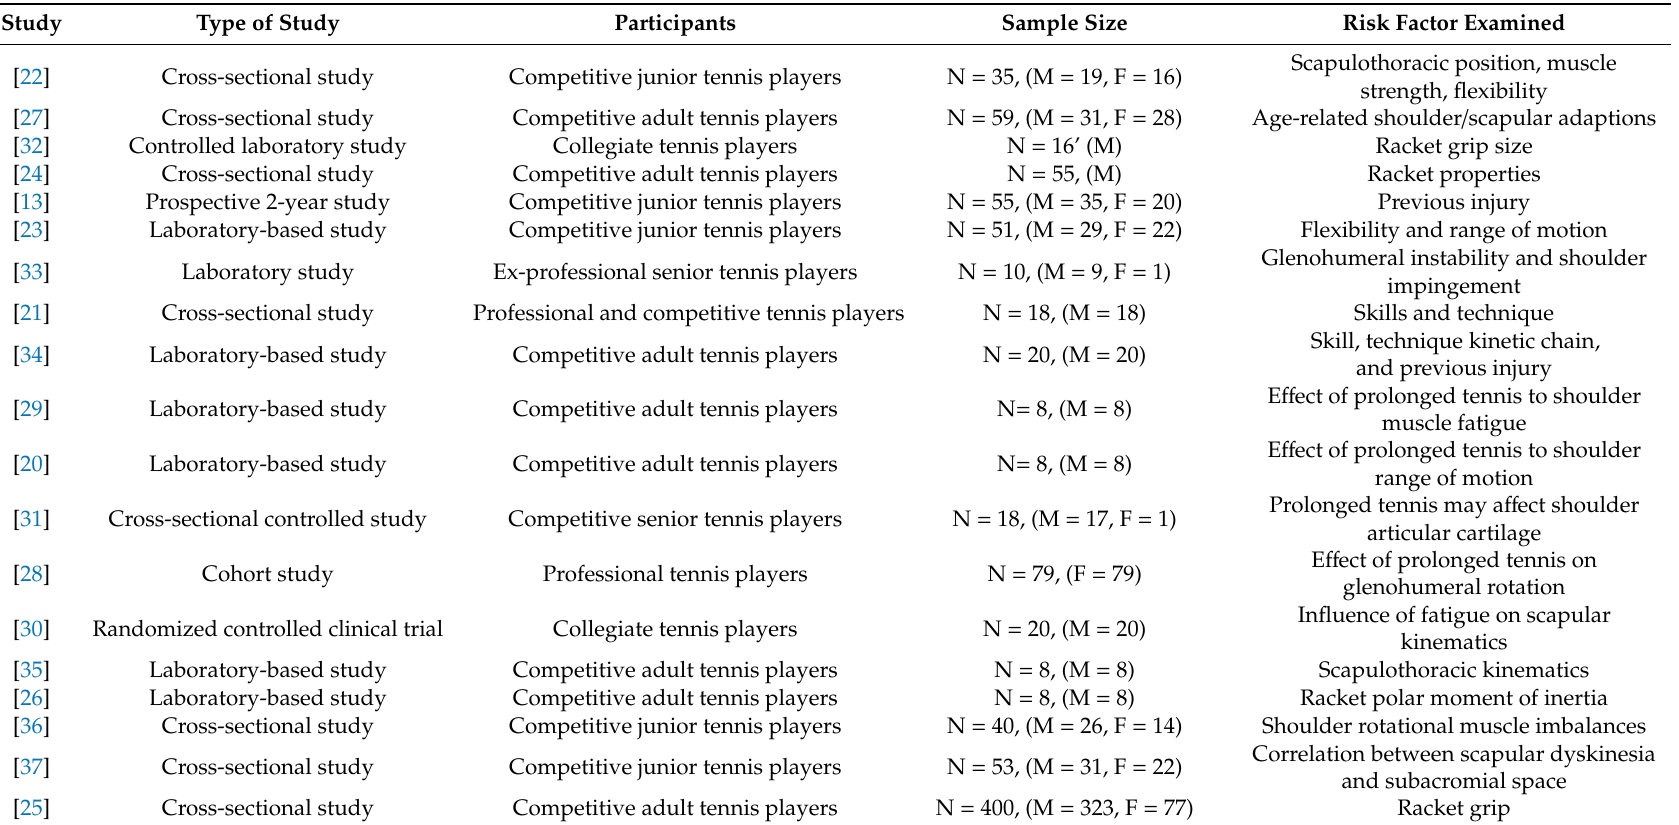
Table 2. Summary of the characteristics of the included